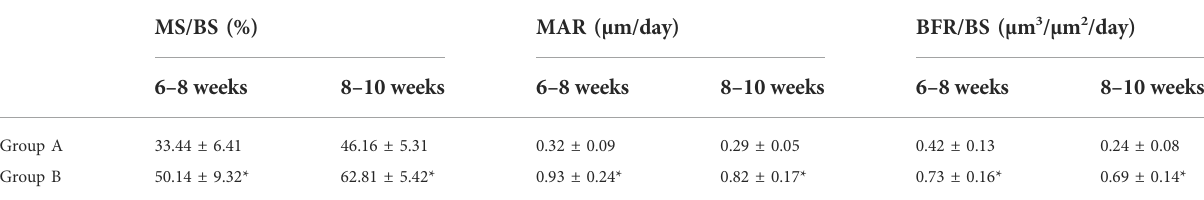
TABLE 1 The calculated parameters in bone histomorphometry.